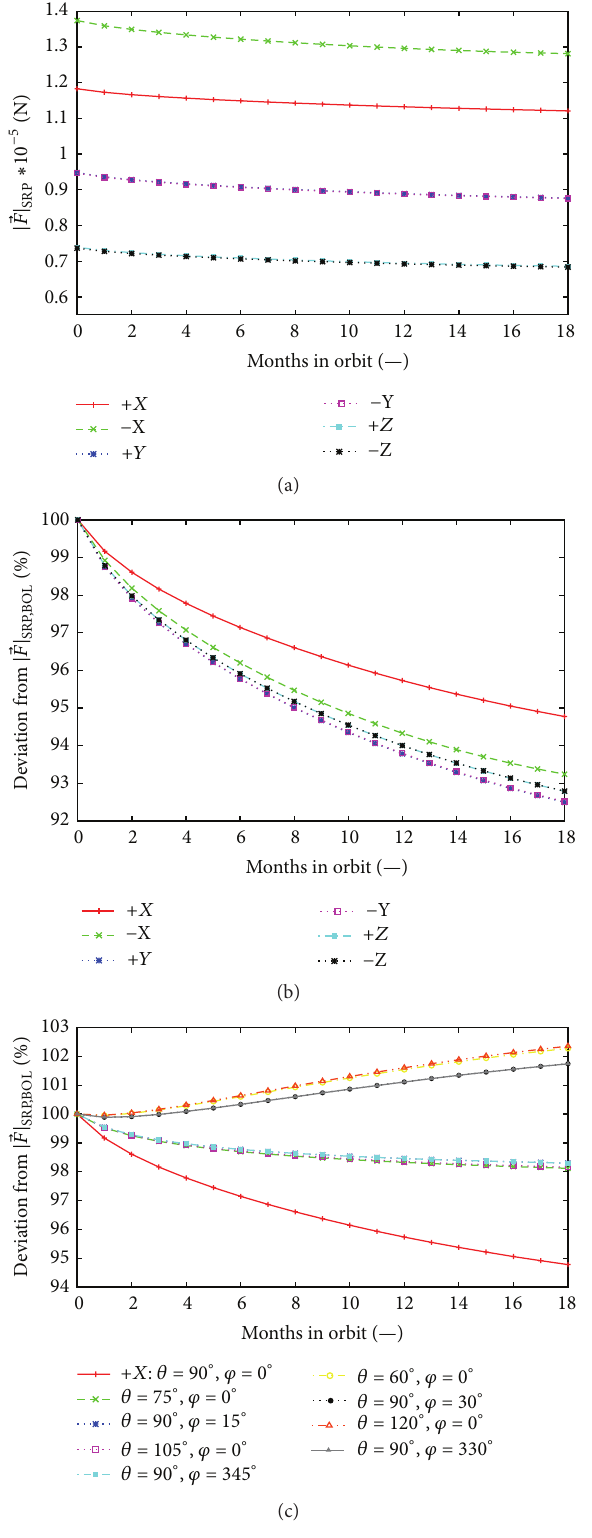
Figure 14: Influence of material degradation on disturbance force due to SRP. (a) Absolute value for perpendicular solar irradiation of each satellite side. (b) Corresponding percentage deviation from BOL value. (c) Percentage deviation from BOL value for illumina- tion conditions that are estimated for MICROSCOPE.